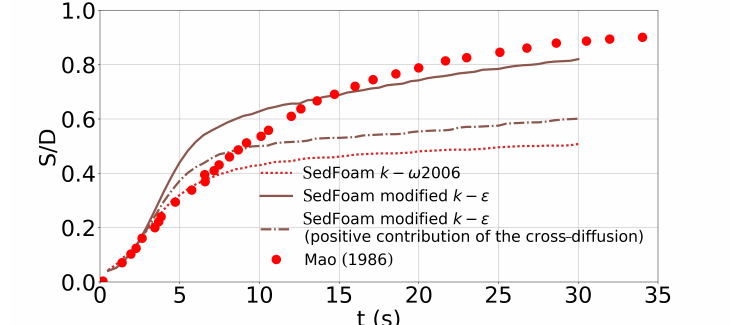
Figure 7. Time evolution of the maximum scour depth from simulations with µ ( I ) rheology using the k − ω 2006 (red dotted line) and modified k − (cid:101) turbulence model with (brown line) and without (brown dashed dotted line) the negative contribution of the cross-diffusion term compared with the experimental data from Mao (1986) [2] (red